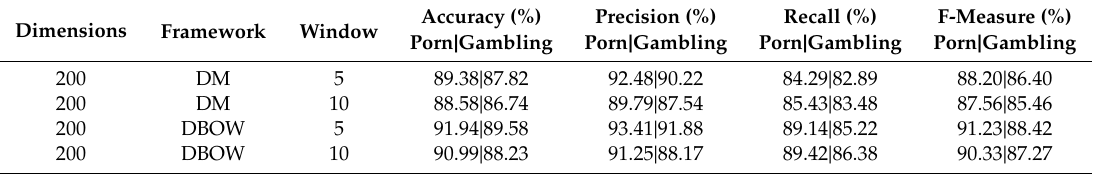
Table 3. Performance of Doc2Vec using di ff erent text window and framework